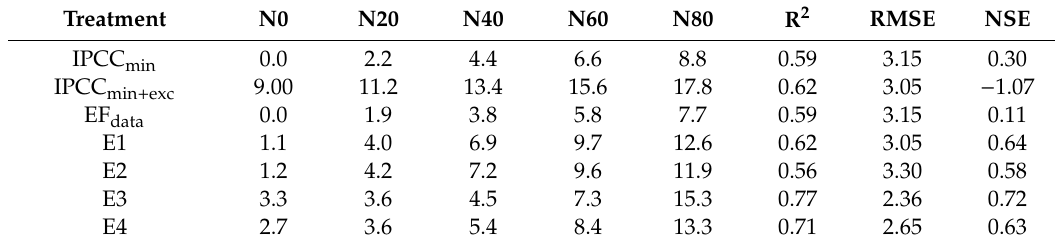
Table 4. The predicted annual N 2 O emissions based on the Intergovernmental Panel on Climate